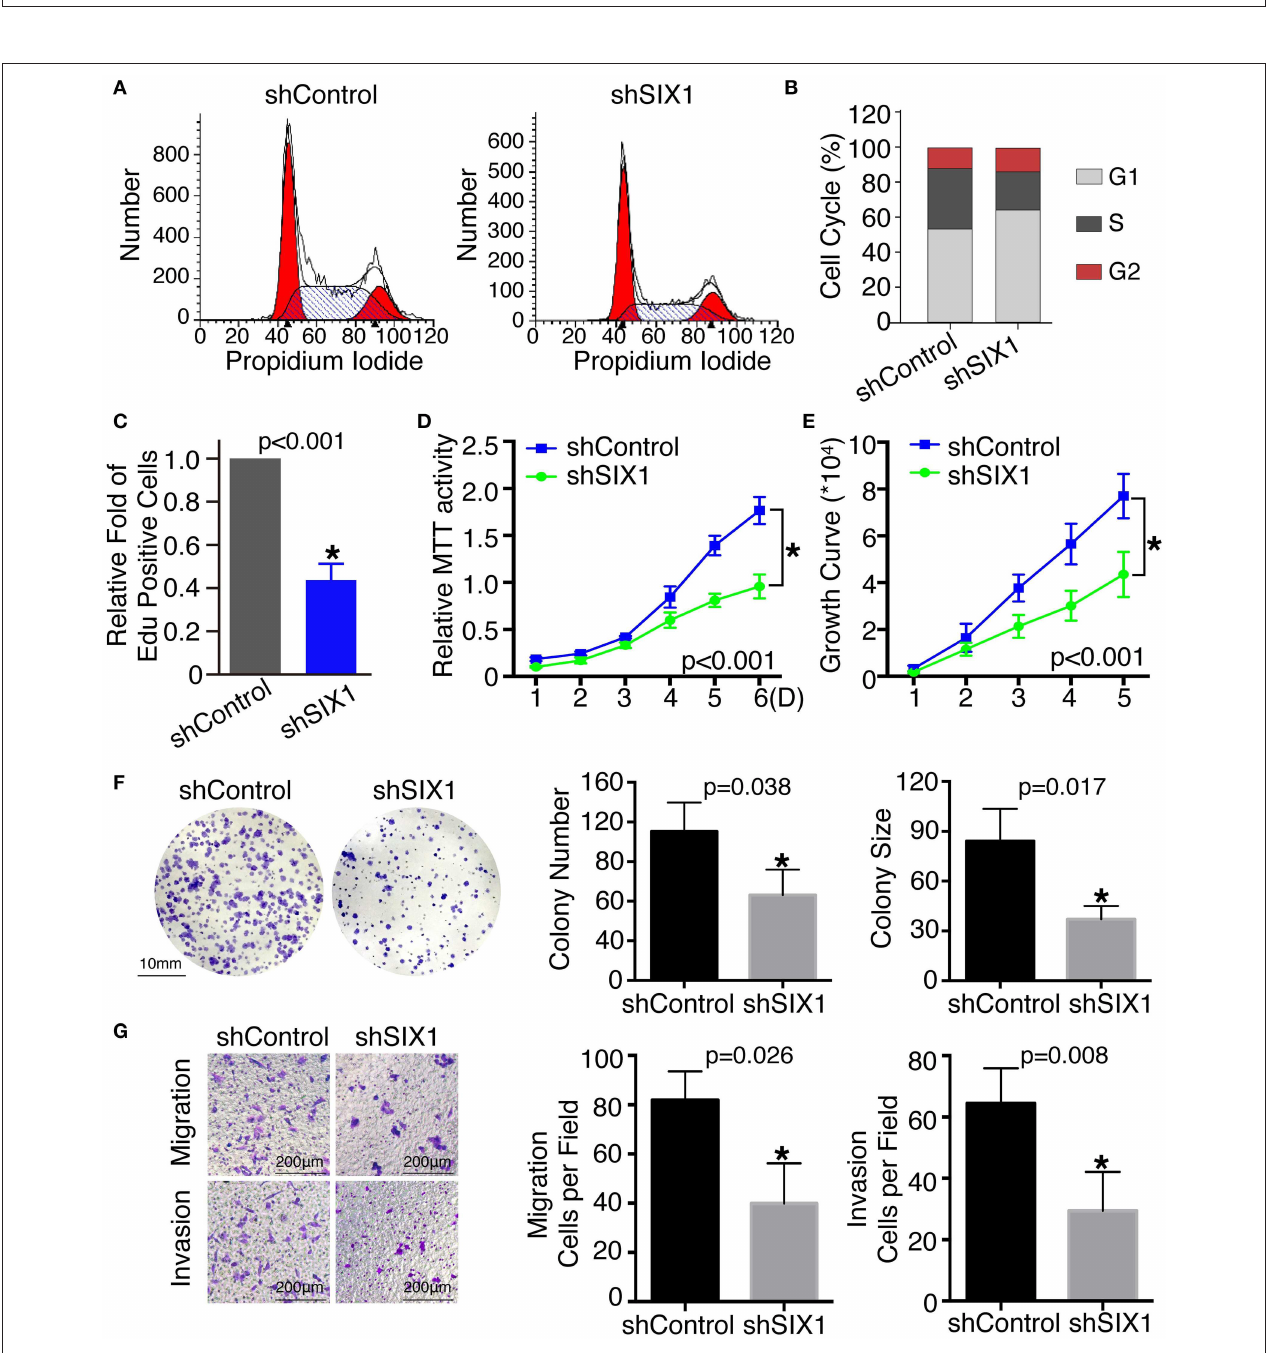
FIGURE 2 | overexpression ( n = 3) (E) . MTT assays of BCPAP cells with ectopic expression of SIX1 ( n = 5) (F) . Growth curve assays of BCPAP cells with ectopic expression of SIX1 ( n = 5) (G) . Representative images of colony formation assays of BCPAP cells with ectopic expression of SIX1 and quantitative results ( n = 3) (H) . The representative images of migration and invasion assay in BCPAP cells with SIX1 overexpression and quantitative analysis ( n = 3) (I) . * p < 0.05.